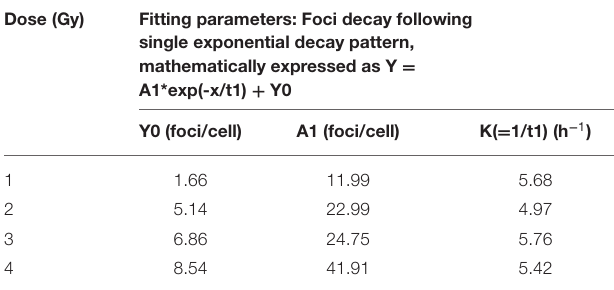
TABLE 1 | Fitting parameters for phospho-53BP1 foci decay for doses 1, 2, 3, and 4Gy up to 24h of incubation after irradiation. Dose (Gy) Fitting parameters: Foci decay following single exponential decay pattern, mathematically expressed as Y = A1*exp(-x/t1) + Y0